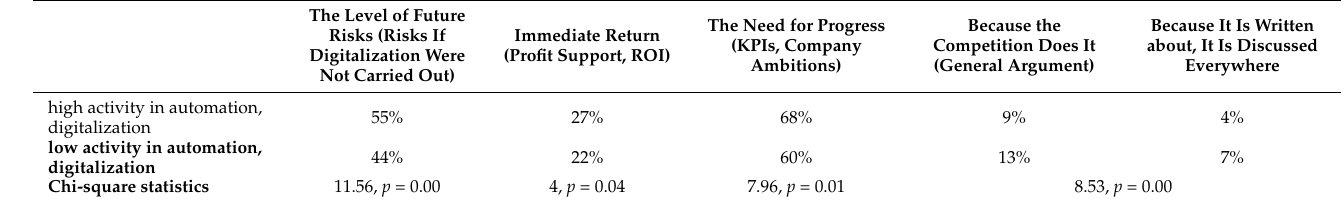
Table 7. Chi square test analysis for arguments for digitalization in context of conducted activity in area of automation,